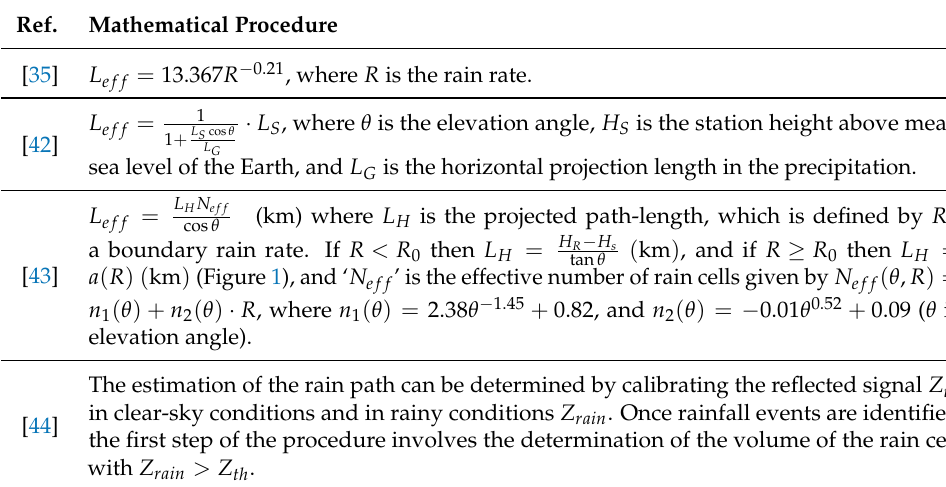
Table 4. Effective path length estimation